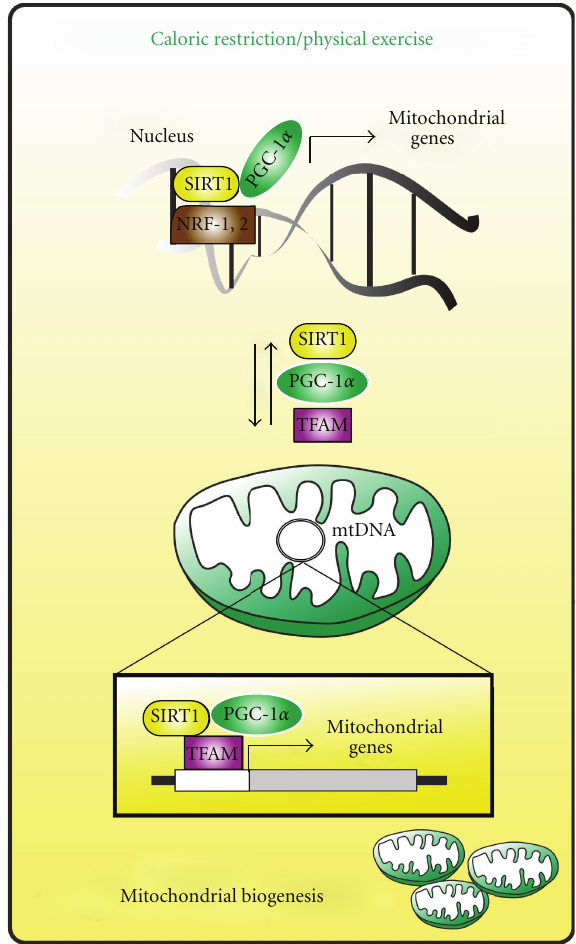
Figure 2: Hypothetical role of extra-nuclear forms of PGC-1 α and SIRT1 in mitochondrial biogenesis. Upon energetic stress conditions (e.g., physical exercise, caloric restriction) PGC-1 α and SIRT1 are implicated in the expression of mitochondrial genes at the nuclear level. Concomitantly, PGC-1 α and SIRT1 might migrate into mitochondrial matrix wherein, by interacting with TFAM, mediate the transcription of mtDNA-encoded mitochondrial genes, thus inducing mitochondrial